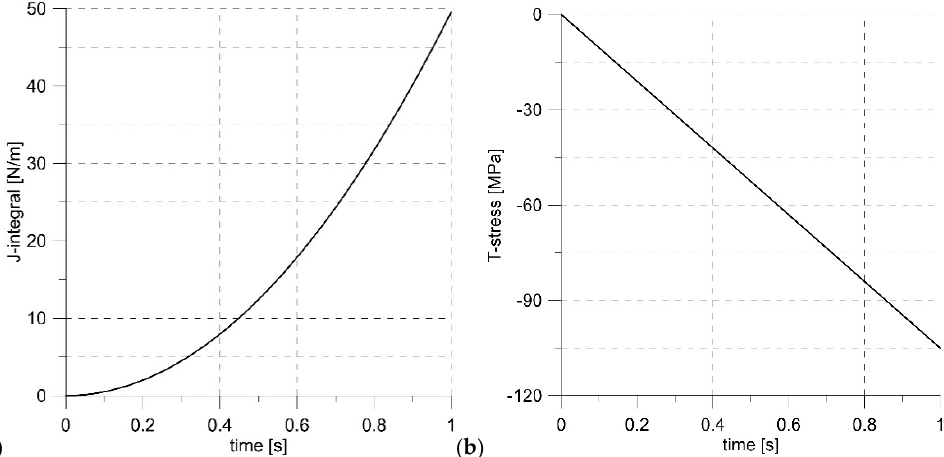
Figure 5 . Changes of the J-integral ( a ) and T-stress ( b ) levels. Figure 5. Changes of the J-integral ( a ) and T-stress ( b )